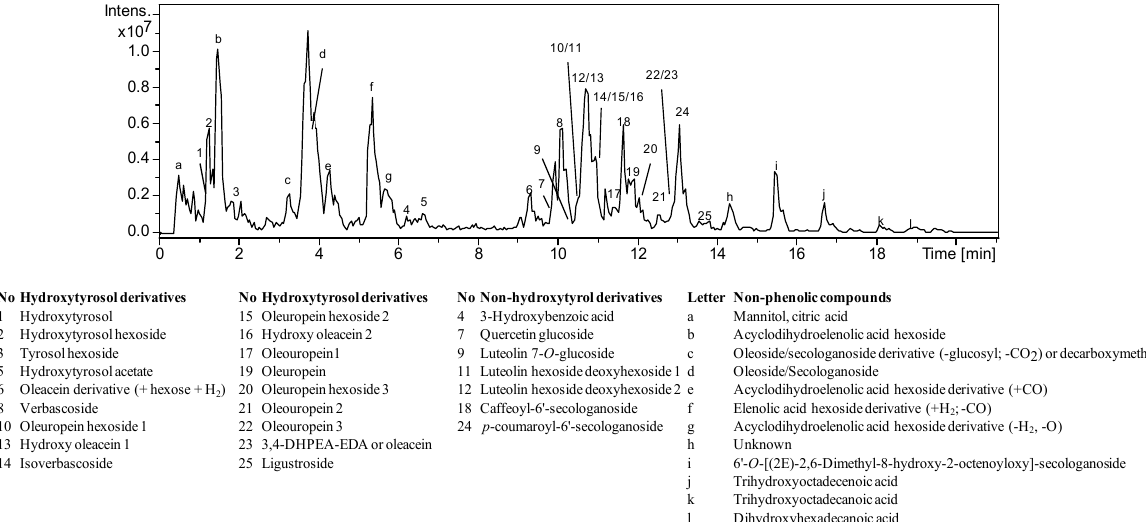
Figure 4. Base peak chromatogram and compounds characterized in the aqueous extracts obtained from pelletized exhausted olive pomace after ultrasound-assisted water extraction at 80% amplitude, 16 min and 11.5% solid loading ( w/v ).